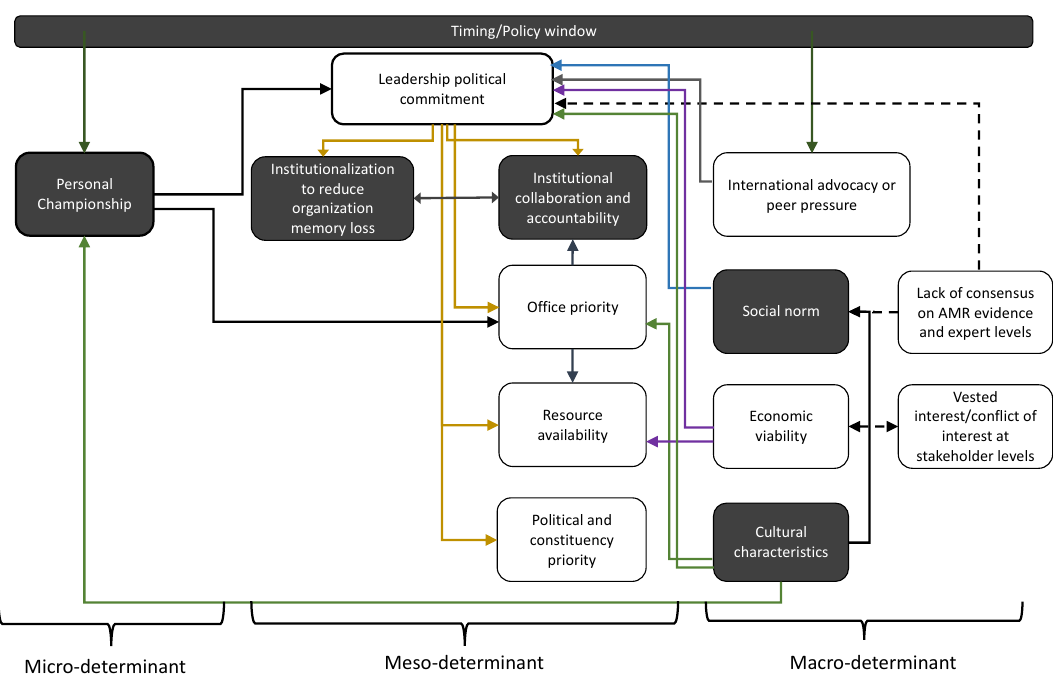
Figure 1. AMR policy protagonists consider multiple variables in their policy advocacy and implementation process. The main themes identified are indicated in black boxes. Solid arrows depict how variables are opined to have facilitated advocacy and/implementation. Dashed arrows depict deterrents in policy development. Yellow arrows depict political, green depict cultural, purple depict economic, and blue depict social characteristics. Micro-, meso-, and macro-determinants are bracketed.